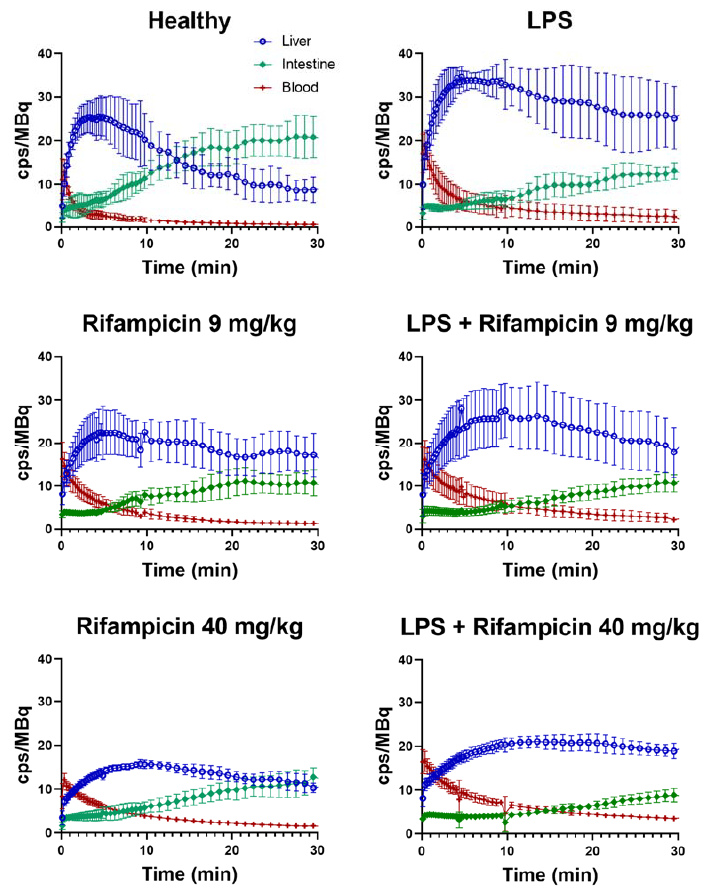
Figure 3. Mean (±SD) time–activity curves of 99m Tc-mebrofenin in the liver ( ○ ), intestine ( ◆ ), and blood (+) of healthy and LPS-treated rats (24 h after exposure to LPS) under baseline conditions and after treatment with 9 or 40 mg/kg rifampicin ( n = 5 for control animals and n = 6 for LPS-treated animals). Radioactivity is expressed as counts per second (cps) normalized to the injected dose (MBq). LPS: lipopolysaccharide. Data obtained in the healthy and Rifampicin 40 mg/kg groups have already been presented in a previous study [29]. High dose rifampicin (40 mg/kg) significantly reduced the amount of 99m Tc-mebrof- enin in the intestines of healthy animals (1.9 ± 0.4-fold, p < 0.001) and LPS-treated animals (1.2 ± 0.3-fold, p < 0.001). High dose rifampicin did not impact liver exposure neither in healthy nor in LPS-treated animals. Rifampicin (9 or 40 mg/kg) increased blood exposure in healthy animals (unpaired t -test, p < 0.01), although no significant difference was found using a one-way ANOVA ( p > 0.05, Figure 4). Rifampicin did not significantly increase blood exposure in LPS-treated animals, regardless of statistical analysis ( p > 0.05, Figure 4). Impact of endotoxemic inflammation and rifampicin-perpetrated DDI on overall blood